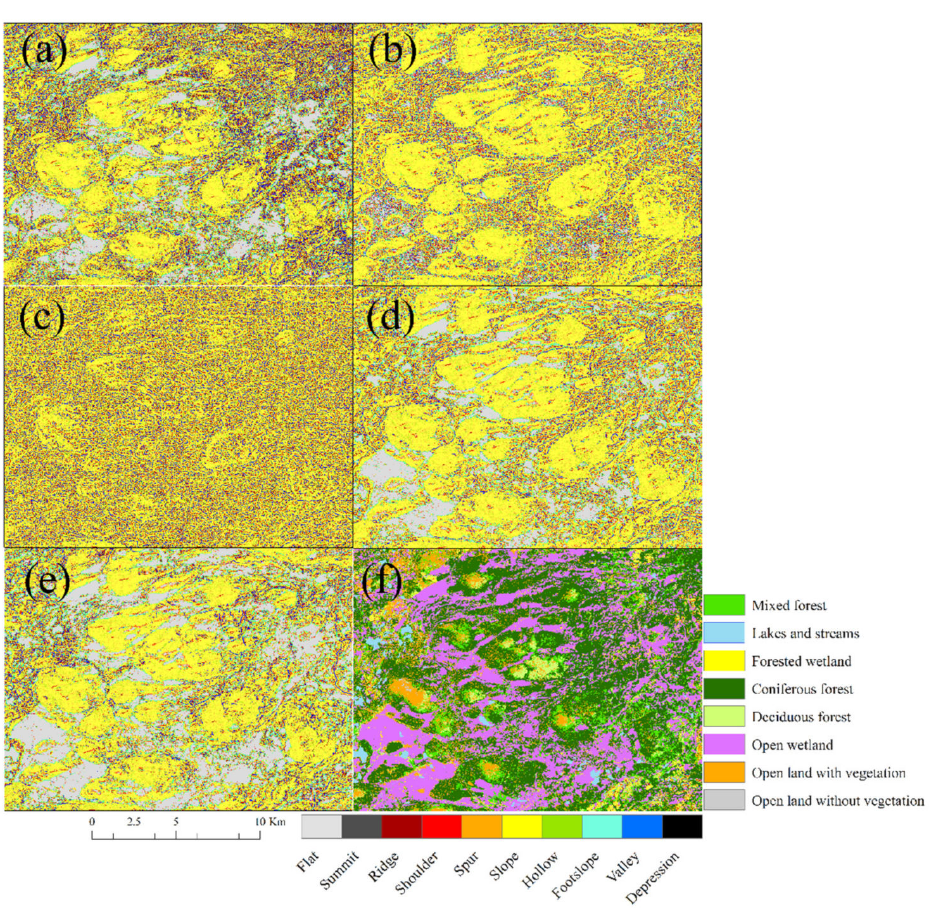
Figure 5. Subsets of landform maps derived from Arctic DEM ( a ), ALOS ( b ), ASTER ( c ), Copernicus ( d ), reference DEM ( e ) and the National Land Cover map ( f ). The horizontal legend refers to the landform classes in ( a – e ), while the vertical legend refers to the land cover classes in ( f